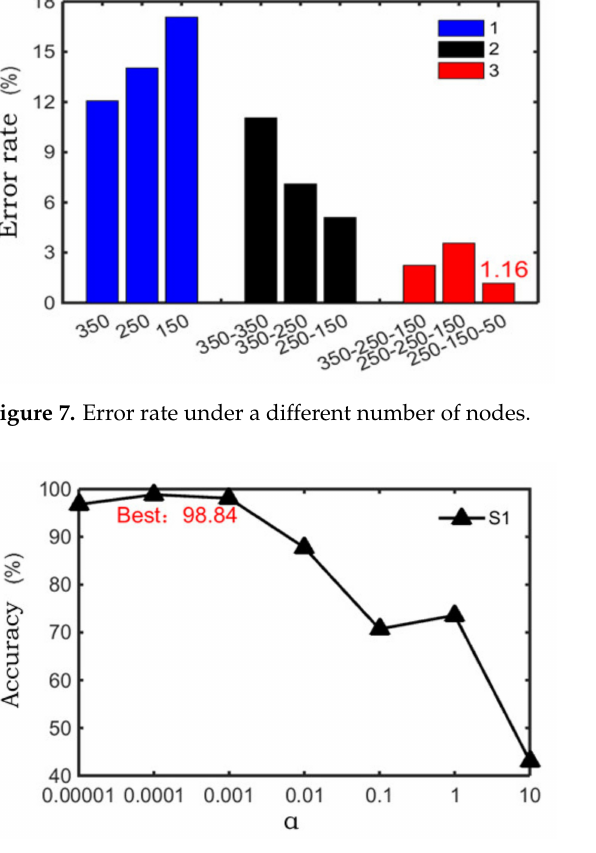
Figure 8. The accuracy under different α